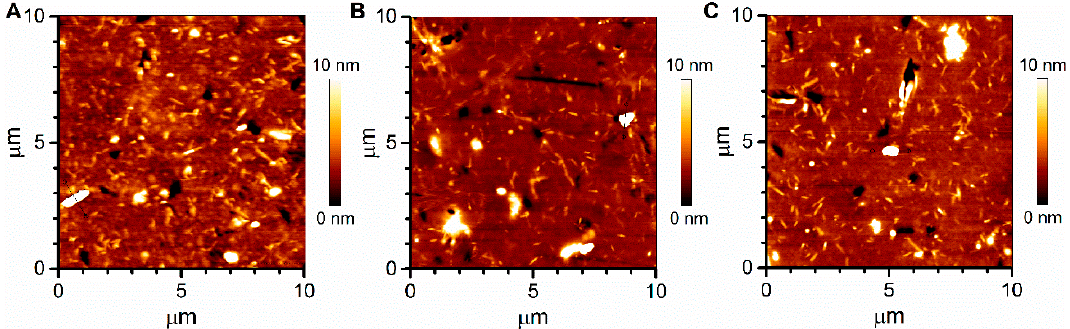
Figure 5. Atomic force microscope images of soft-imprinted [Zn 2 (bpdc) 2 (bpee)] powder on CA/quartz